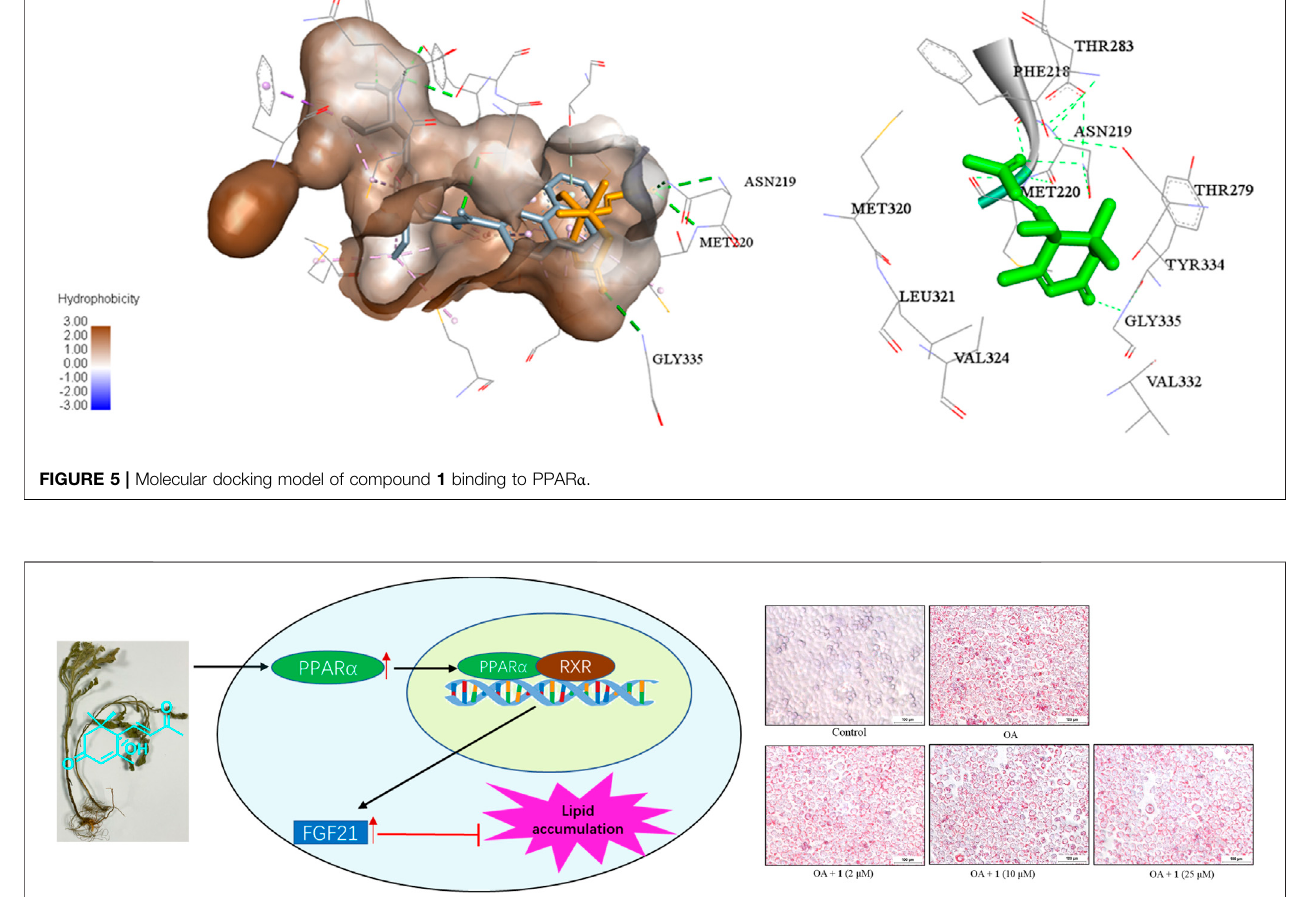
Frontiers in Pharmacology |